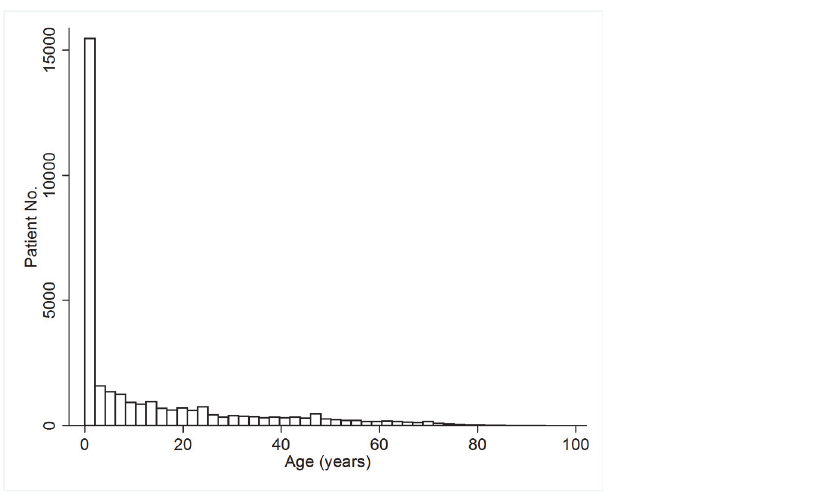
Fig 1. Distribution of age at diagnosis of congenital heart disease